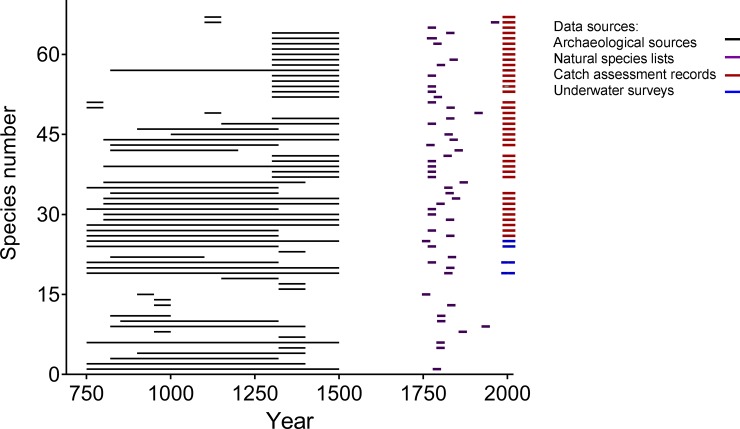
Sightings of historically exploited species reconstructed over time using a suite of disparate data sources.The colour of the line represents from where the coral reef species data were sourced from: archaeological remains (black), naturalists species lists (purple), catch assessment records (red) and underwater surveys (blue).